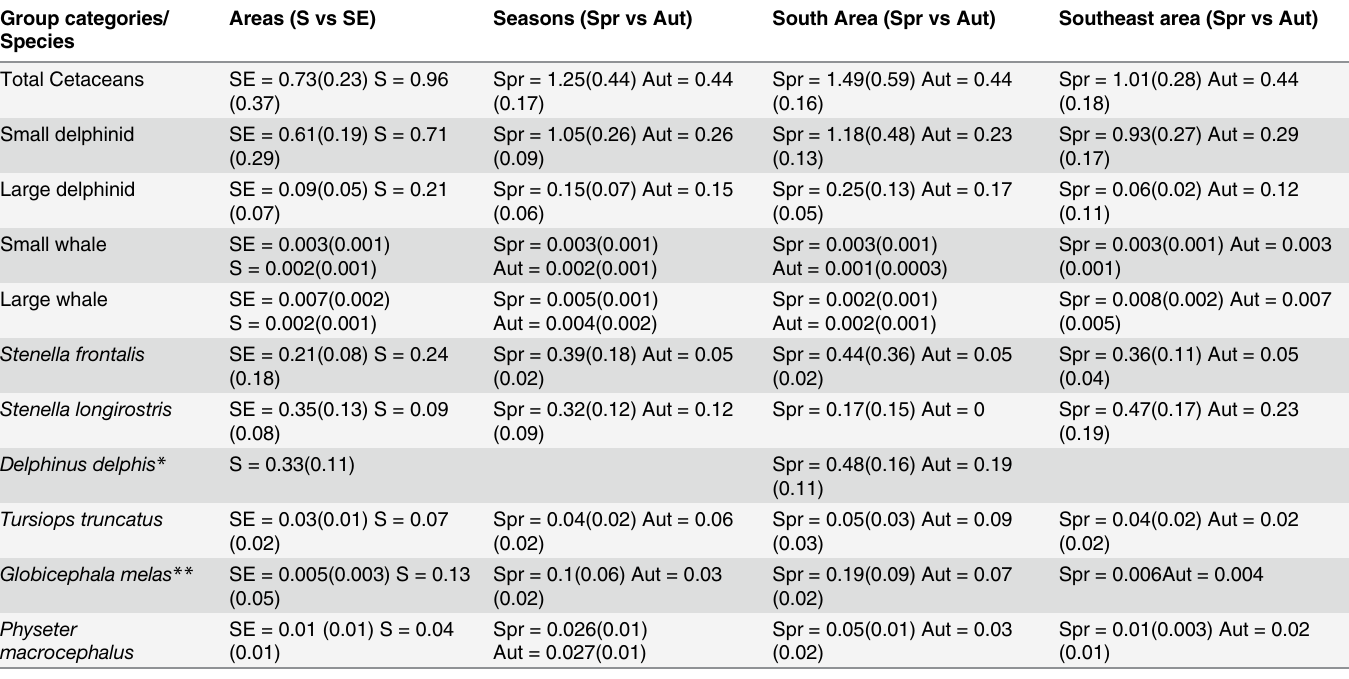
Table 5. Mean ER values for each area (South and Southeast) and season (Spring and Autumn).